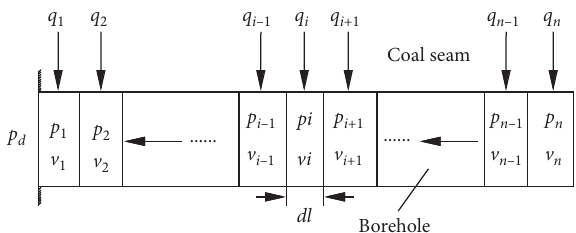
Figure 3: Schematic diagram of the calculation of negative pressure in a